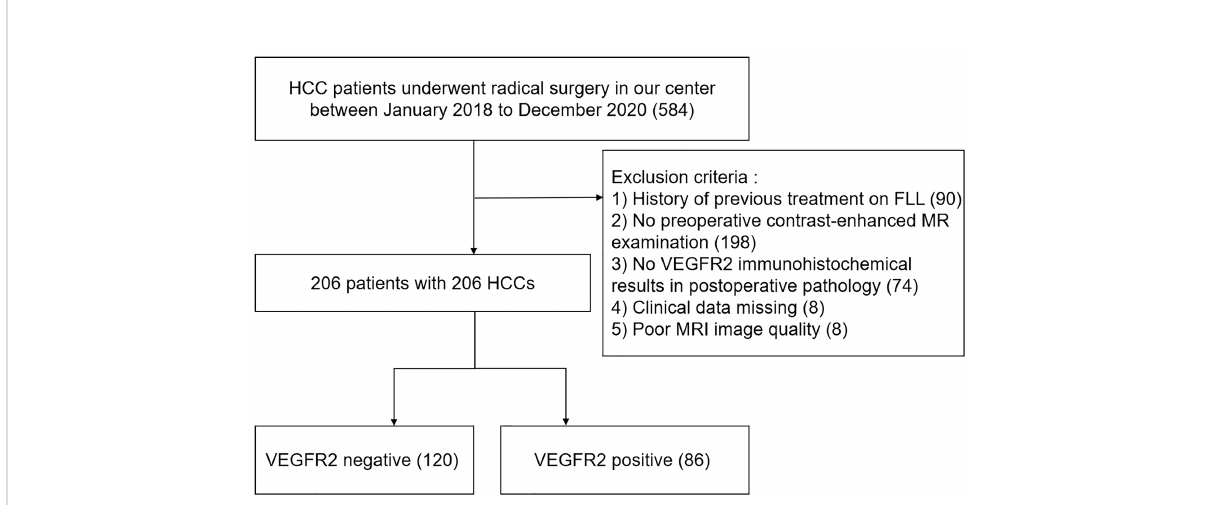
FIGURE 1 Flowchart of patient selection. HCC, hepatocellular carcinoma; MRI, contrast-enhanced magnetic resonance imaging; FLL, focal liver lesion; VEGFR2, vascular endothelial growth factor receptor